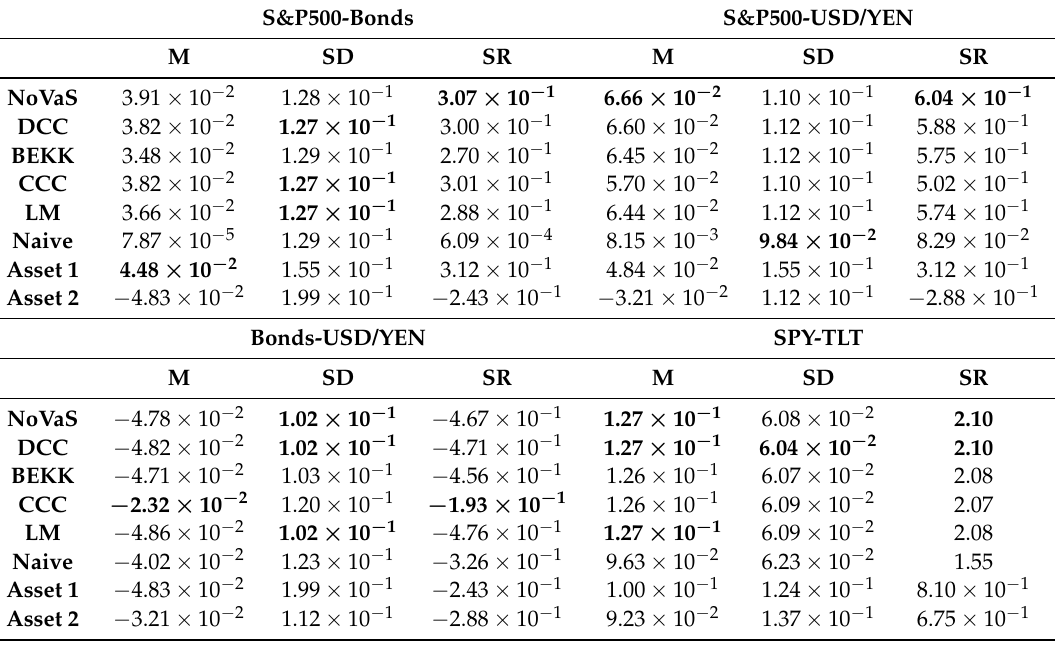
Table 9. Mean (M), standard deviation (SD) and Sharpe ratio (SR) of portfolio returns, where the portfolio weights are chosen as in Equation (34), with the correlation estimated with the methods in the left column. The NoVaS transformation used is the one that performed best in Table 7. Naive assumes an equally weighted portfolio. Linear model estimates the conditional correlation based on linear